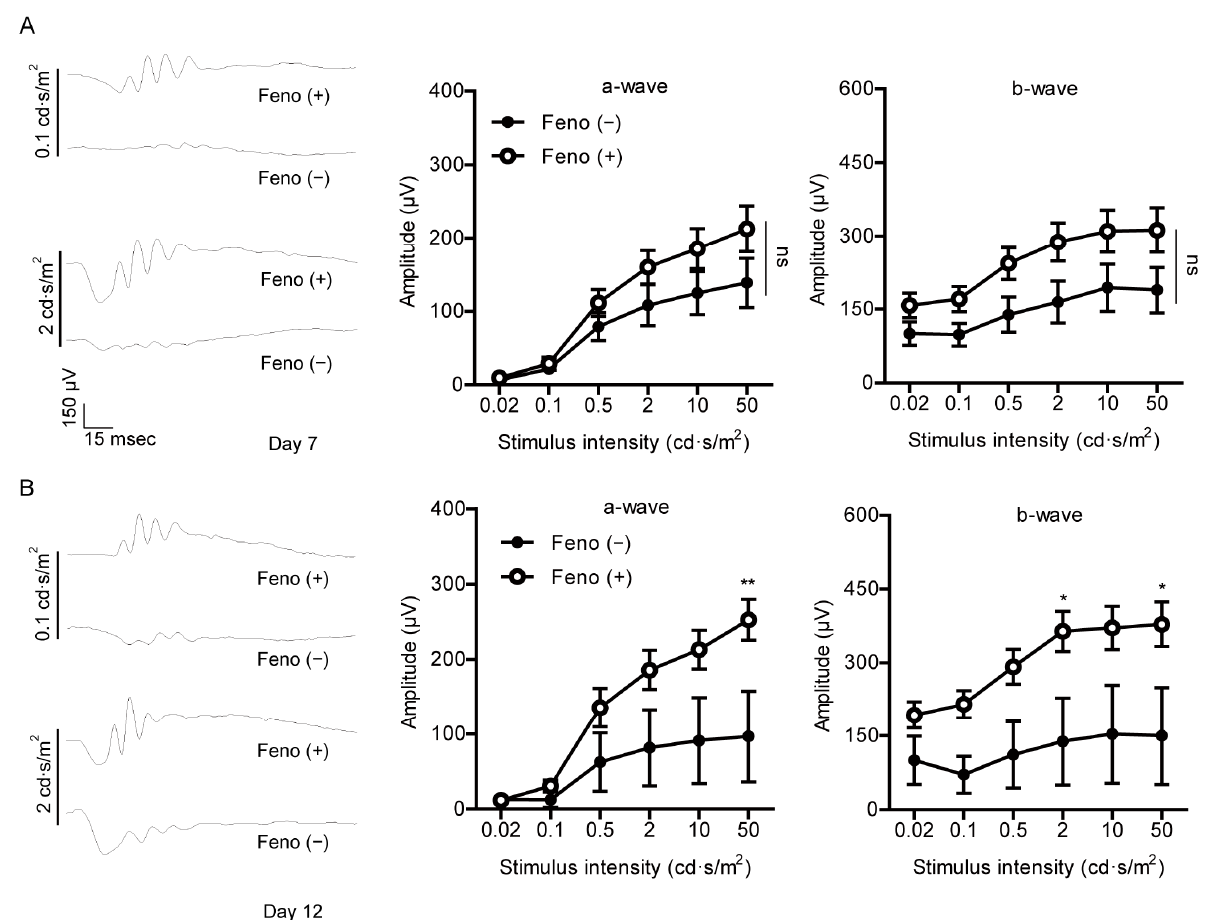
Figure 3. Protective effects of fenofibrate against retinal dysfunction induced by UCCAO. ( A ) Representative waveforms of a- and b-waves (low and high intensities, 0.1 and 2 cd · s/m 2 , respectively) and quantitative analyses ( n = 9–11 per group) show that oral administration of fenofibrate slightly suppressed reduction in the amplitude of b-wave in the UCCAO-operated eye 7 days after UCCAO. ( B ) Representative waveforms of a- and b-waves (low and high intensities, 0.1 and 2 cd · s/m 2 , respectively) and quantitative analyses ( n = 5–6 per group) show that oral administration of fenofibrate dramatically suppressed reduction in the amplitude of b-wave in the UCCAO-operated eye 12 days after UCCAO. * p < 0.05, ** p < 0.01. The data were analyzed using two-way ANOVA followed by a Bonferroni post hoc test and presented as mean ± standard error of the mean. Feno; fenofibrate. UCCAO; unilateral common carotid artery occlusion.